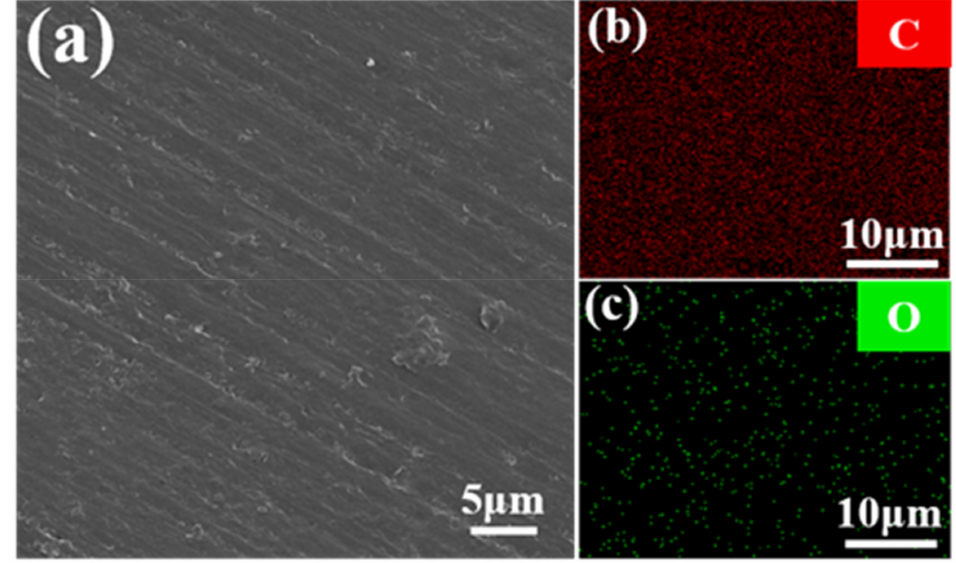
Figure 4. ( a ) SEM image of plastic board, ( b ) elemental distribution of C and ( c )